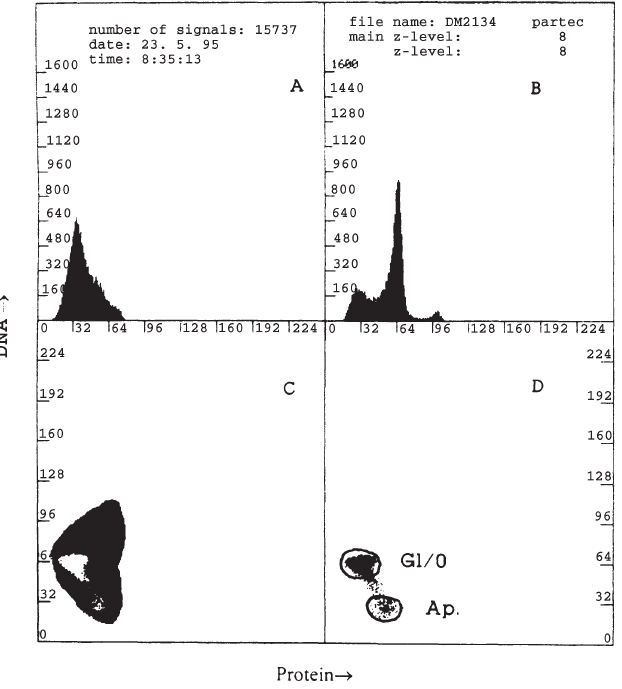
Fig. 3. Bivariate DNA/protein content distribution of a DNA diploid mucosal biopsy. Apoptotic cells (Ap) are indicated. (A) protein histogram: cellular protein content ( x -axis) is plotted vs. cell number ( y -axis). (B) DNA histogram: cellular DNA content ( x -axis) is plotted vs. cell number ( y -axis). (C) DNA/protein scatter diagram: cellular protein content ( x -axis) is plotted vs. cellular DNA content ( y -axis). The region for gating of cells is indicated. (D) equal to (C) without gated region. Apoptotic cells are characterised by diminished DNA content and slightly increased protein content compared to G1/0 cells. Table 1 Cell cycle distribution, subdiploid apoptotic fraction and Ki67 positive